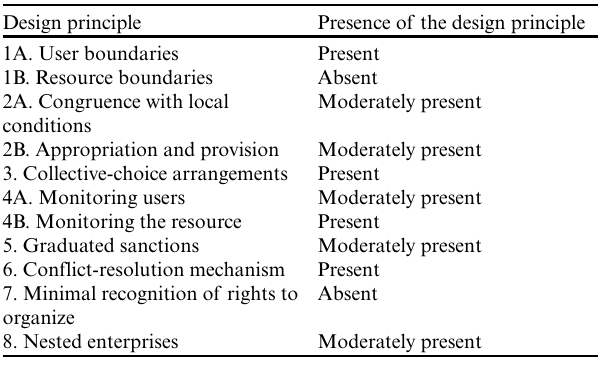
Table 1 . Presence of the design principles in the British Columbia carbon tax case